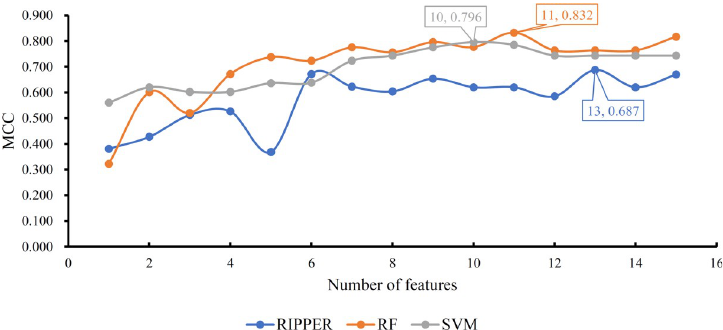
Fig 2. IFS curves based on the ordered features from RF, SVM, and RIPPER. The model with RF and top 11 features is the best, which produces the MCC of 0.832.